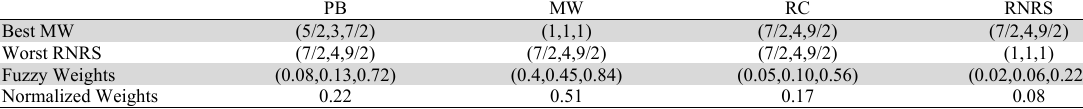
Best-Worst value for the Sub-group 2 (Sustainability)